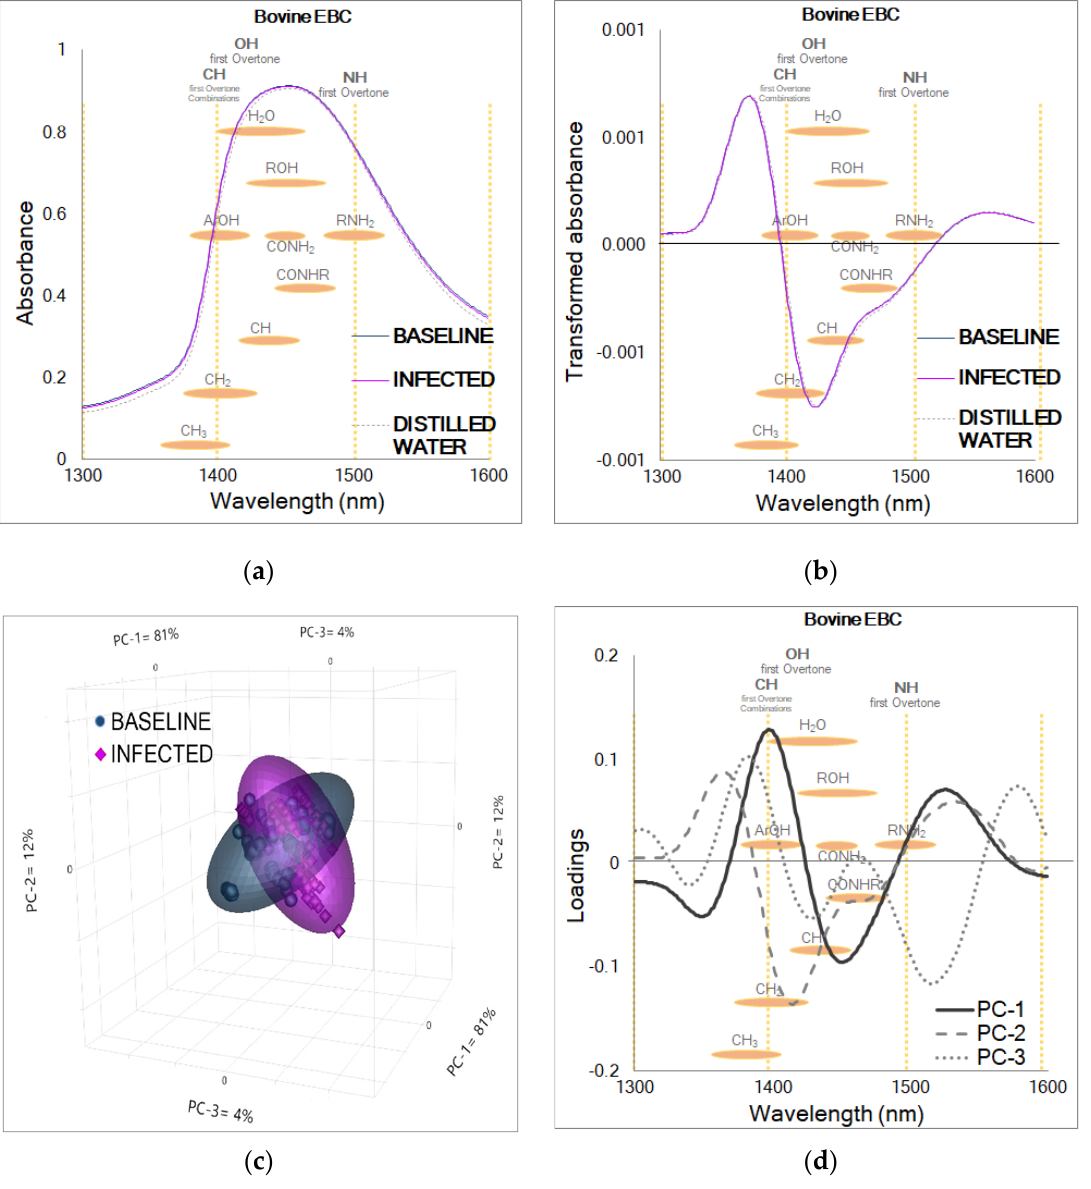
Figure 2. NIR absorbance from bovine EBC collected before and after BRSV infection. ( a ) Raw or unprocessed NIR absorbance from baseline ( n = 100) and infected ( n = 100) stages relative to infection, showing the characteristic water spectral pattern. ( b ) Transformed or processed absorbance from baseline ( n = 100) and infected ( n = 100) stages displaying two prominent features at 1376 and 1424 nm. ( c ) PCA scores plot for samples of the baseline and infected stages from all the calves ( n = 5) challenged in this study ( n = 200). ( d ) PCA loadings showing the dominant peaks influencing the positive and negative trends in the scores plot: PC-1 = 81%, PC-2 = 12%, PC-3 =